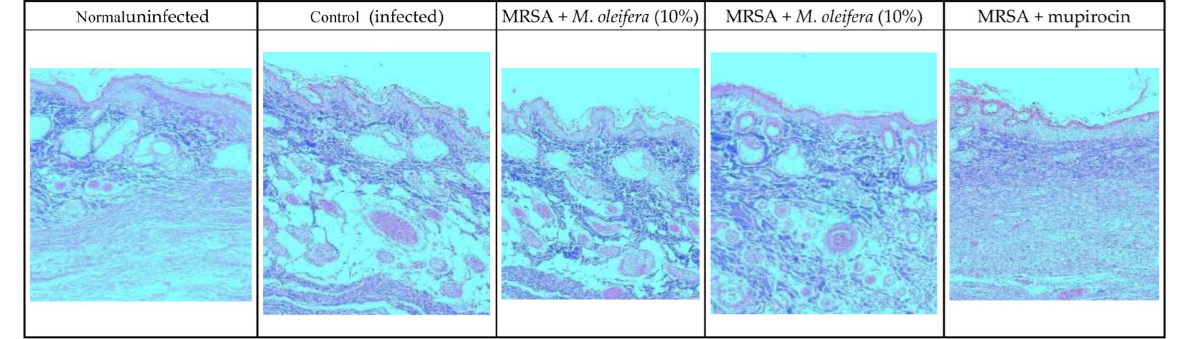
Figure 10. Effect on the period of epithelization in P. aeruginosa (Pa) ‐ infected wounds in rats. All values are mean ± SEM, n = 6, *** p < 0.001 when compared to control (infected). Antioxidant enzymes; SOD and catalase activities were decreased in P. aeruginosa in ‐ fected wounds. However, the application of the extract (20 % w/w ) increased these enzyme activities, whereas a lower concentration (10% w/w ) had a limited effect on antioxidant enzymes. Application of gentamicin on P. aeruginosa ‐ infected wounds promoted wound healing and increased antioxidant enzymes (Figure 11).